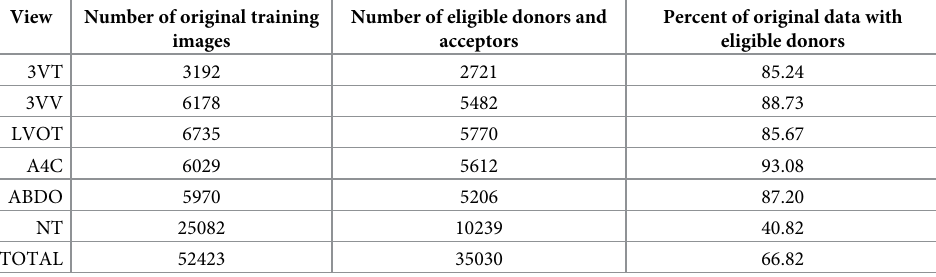
Table 3. Number and class distribution of cut-paste eligible images.